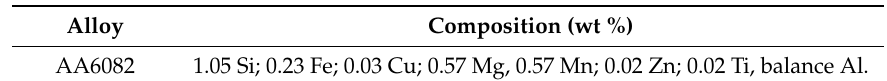
Table 2. Composition of the coupons used as substrate.